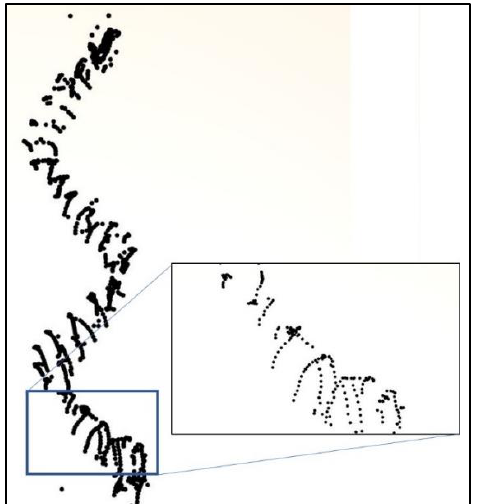
Figure 8. Camera stations (black dots) from the survey of section N04-N05 of the spiral stairs.